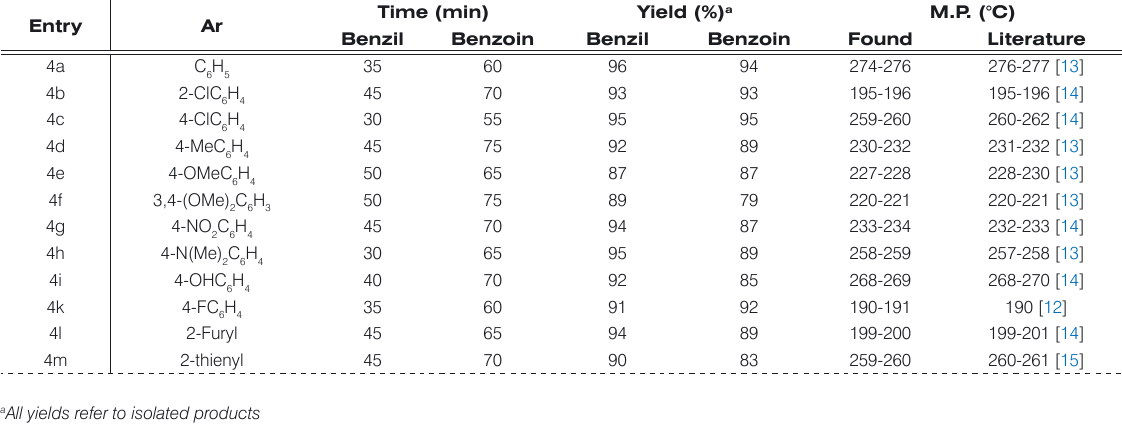
Table 2. Synthesis of 2,4,5-triaryl-1H-imidazole derivatives in EtOH using benzil or benzoin, ammonium acetate, aromatic aldehydes, and 2 wt% scolecite catalyst.